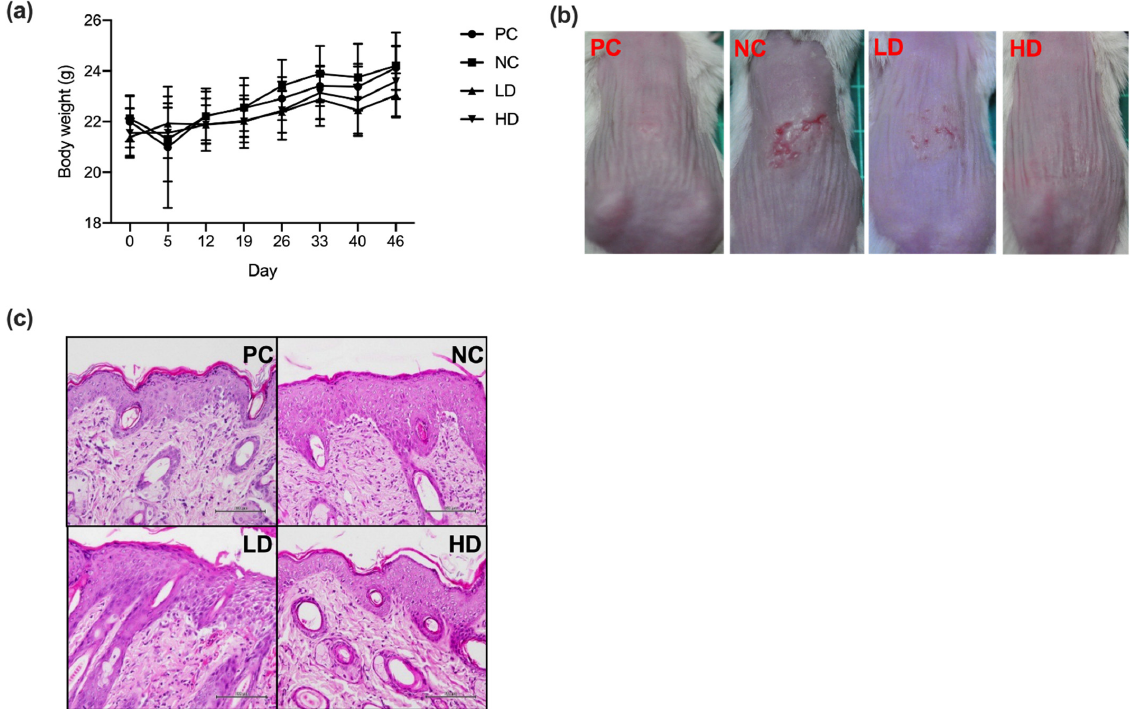
Figure 2. A combination of heat-killed MP01 and MP02 strains alleviated skin lesions of HDM-extraction induced AD mice. ( a ) The body weight of mice after treatment for 46 days. Value represents means ± SD. (n = 7–10/group) ( b ) The skin lesion induced by the HDM extraction in NC, PC, LD, and HD groups. Aspects of dermatitis in AD mice were examined on day 45. ( c ) Histological section of skin of the HDM-induced AD in NC, PC, LD, and HD groups. The dorsal skin from mice was stained by hematoxylin and eosin stain, and the slides were examined under 400× magnification. 3.3. A Mixture of Heat-Killed MP01 and MP02 Strains Regulated the Number of Th1 and Th2